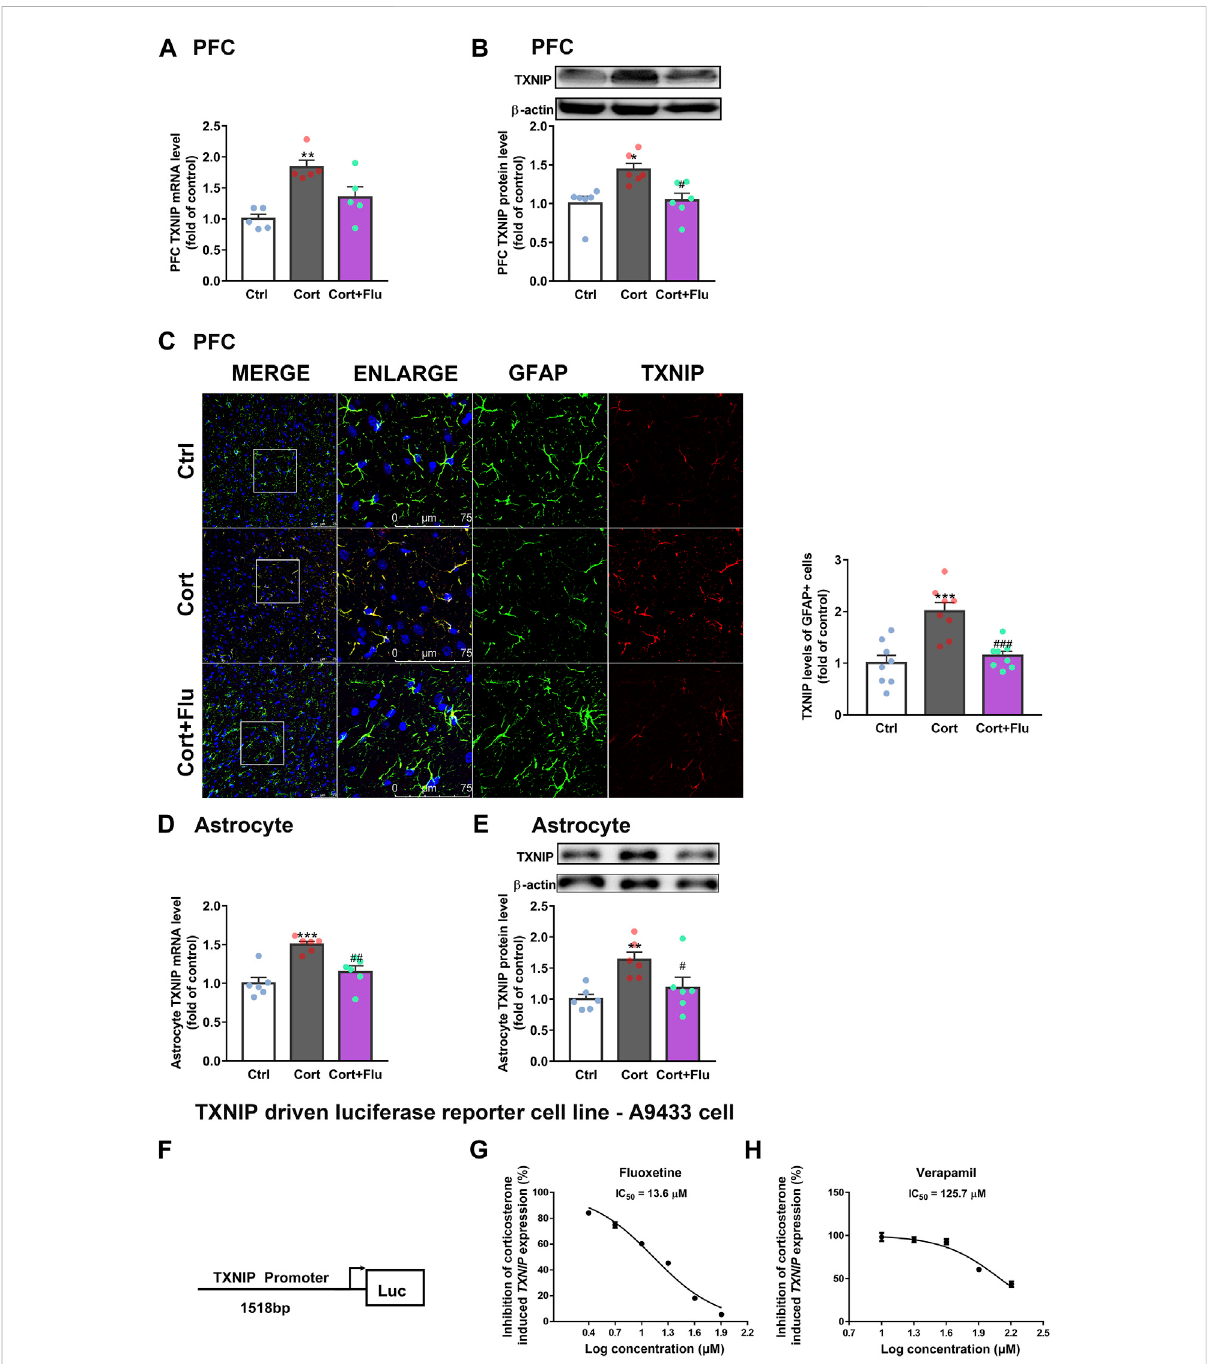
FIGURE 5 Fluoxetine restricts the transcription of TXNIP under corticosterone-induced depressive state. (A,B) TXNIP mRNA [ (A) , n = 5 animals/group; P CortxCort+Flu=0.2744)]andproteinlevels[ (B) , n =6animals/group; P CortxCort+Flu=0.0116)]inPFCofratstreatedwith fl uoxetine(10 mg/kg). (C) Immunostaining of GFAP (green), TXNIP (red) and DAPI (blue) in PFC of rats treated with fl uoxetine (10 mg/kg), scale bar = 75 μ m. The fl uorescence intensity was calculated by ImageJ, n = 8 fi elds/group. The fl uorescence intensity of TXNIP (red) was normalized by GFAP (green); P CortxCort + Flu=0.0006. (D,E) TXNIPmRNA[ (D) , n =6cellcultures/group; P CortxCort+Flu=0.0039)]andproteinlevels[ (E) , n =6cellcultures/group; P CortxCort + Flu = 0.0466)] in fl uoxetine (5 μ M)-treatedprimary astrocytes. (F) A human TXNIP promoter ( > 1518bp + 50 UTR) connecting with luciferase reporter wasstablytransfectedintoU87MG. (G) A9433cellsexposedto100 nMcorticosteronewastreatedwith fl uoxetineatdifferentconcentrations(2.5,5,10, 20,40,and80 μ M, n =3cellcultures/group). (H) A9433cellsexposedto100 nMcorticosteroneweretreatedwithverapamilatdifferentconcentrations (10,20,40,80,and160 μ M, n =3cellcultures/group).Alldatawereexpressedasmean±SEM,** p < 0.01,*** p < 0.001vs.Ctrl(control)group, # p < 0.05, ## p < 0.01, ### p < 0.001 vs. Cort (corticosterone) group (Normality of data was checked by Shapiro-Wilk test. Data with or without normal distribution were analyzed by one-way ANOVA or Kruskal-Wallis test followed by Dunnett ’ s post-hoc test for multiple